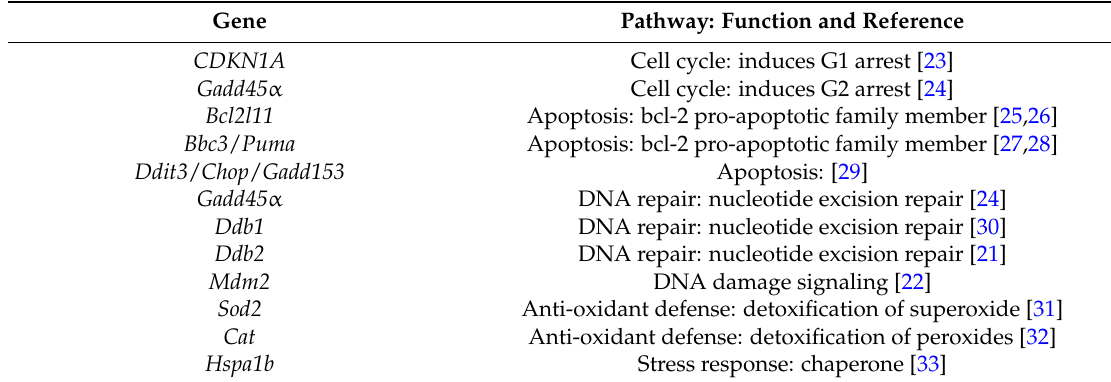
Table 1. FoxO3a-regulated genes chosen and validated for this study a . Gene Pathway: Function and